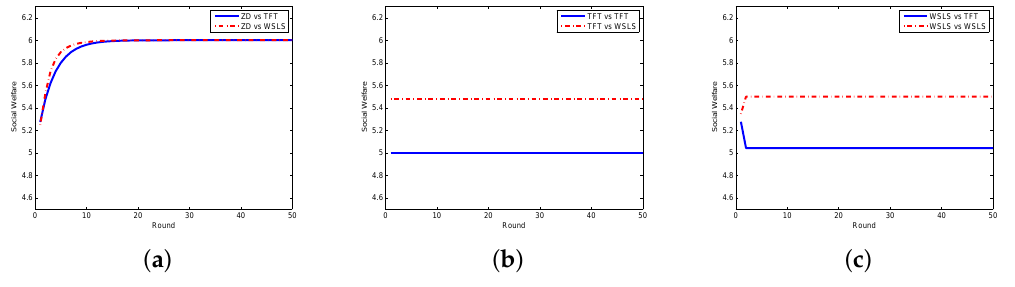
Figure 7. Social welfare with different strategy pairs (requestor vs. worker) among ZD, TFT, and WSLS in the continuous model. ( a ) requestor adopts the ZD strategy; ( b ) requestor adopts the TFT strategy; and the ( c ) requestor adopts the WSLS